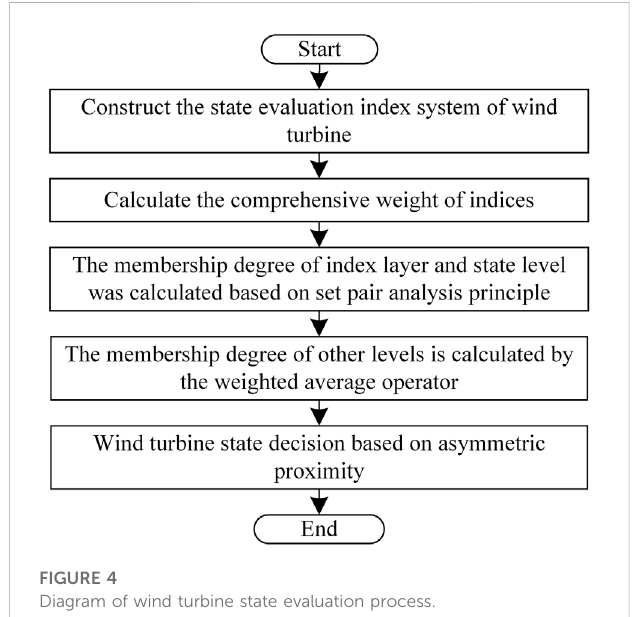
FIGURE 4 Diagram of wind turbine state evaluation process.